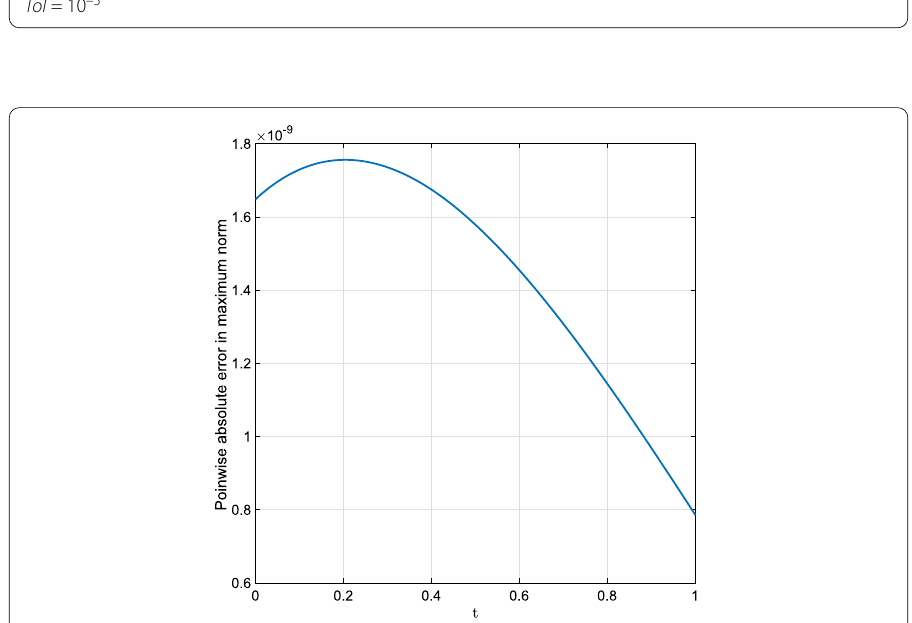
Figure 9 Poinwise absolute errors in maximum norm obtained by the proposed shooting technique with Halley’s method of Example 4.5 versus the time step h when ( α 1 , α 2 ) = (1 – 10 –16 ,1.7), s 0 = 0.2, N = 320, Tol = 10